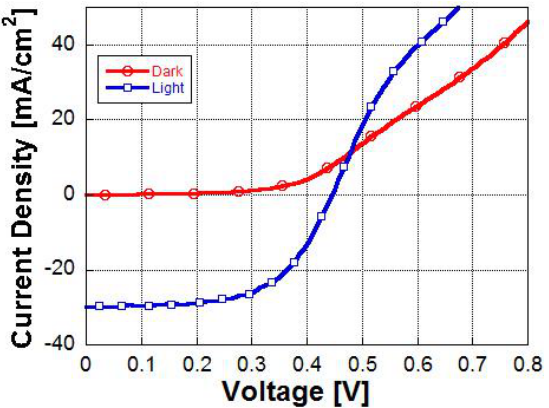
Figure 2. Dark (red circles) and illuminated (blue squares) characteristics of a CIGS solar cell where the absorber layer is deposited at 500 °C. The corresponding cell parameters are: Voc = 444 mV, absorber layer is deposited at 500 ˝ C. The corresponding cell parameters are: Voc = 444 mV, FF = 58.6%, FF = 58.6%, Jsc = 30.1 mA/cm 2 ,  = 7.8%. Jsc = 30.1 mA/cm 2 , η =